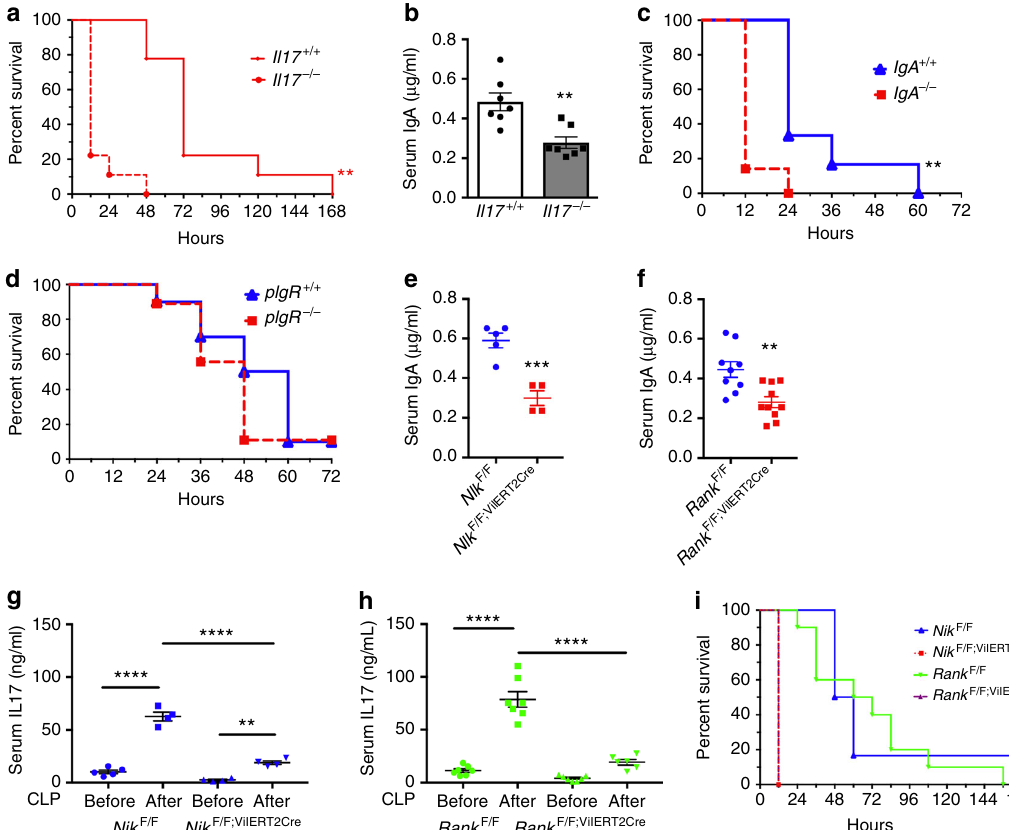
Fig. 7 Loss of epithelial RANK/NIK accentuates polymicrobial sepsis. a Percent survival assessed in 6-week-old Il17 − / − mice following cecal ligation and puncture (CLP); n = 9 mice/group. b Serum IgA assessed in 6-week-old Il17 − / − mice. c Percent survival assessed in 6-week IgA − / − after CLP; n = 6 – 7 mice/group. d Percent survival assessed in 6-week pIGR − / − after CLP. e , f Serum IgA in Nik F/F;VilERT2Cre ( e ), and Rank F/F;VilERT2Cre mice ( f ). g – i Serum IL17 in Nik F/F;VilERT2Cre ( g ) and Rank F/F;VilERT2Cre mice ( h ) assessed at 6 h post CLP, and percent survival assessed after CLP ( i ). For CLP n = 6 – 9 mice/group. Results are expressed as mean ± SEM. Signi fi cance determined using t test or one-way ANOVA or log-rank test (survival). * P < 0.05; ** P < 0.01; *** P < 0.001; **** P <